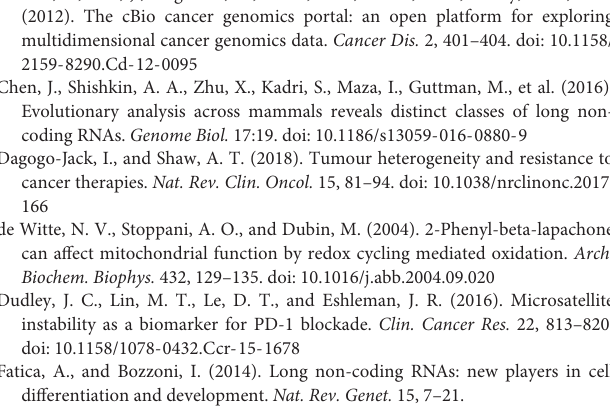
Supplementary Figure 3 | The association between the three lncRNAs ( BOLA3-AS1 , AC124067.4 , and AL161772.1 ), four target mRNAs ( NINL , SALL4 , TNFSF11 , PHYHIPL ), and each specific type of immune cell based on the CIBERSORT